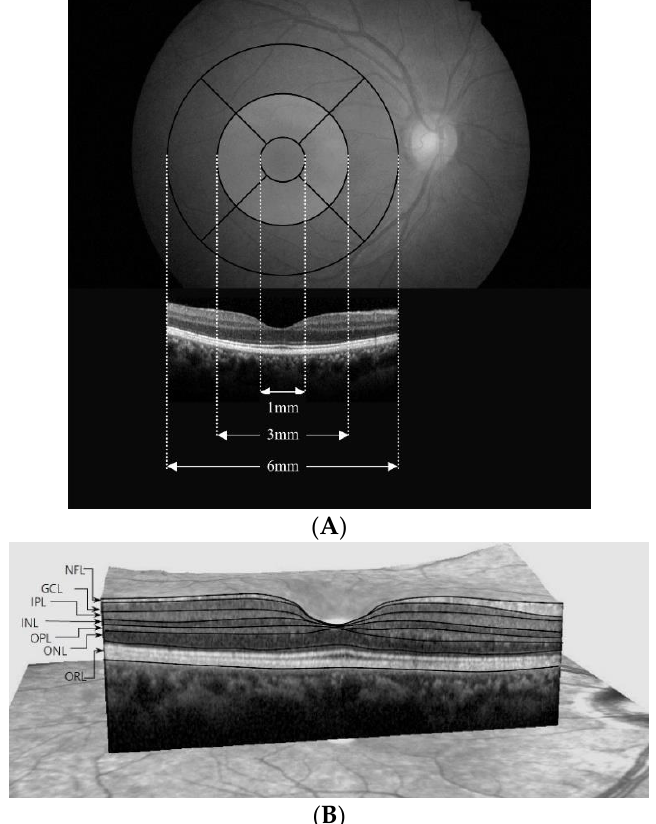
Figure 1. ( A ) The Early Treatment Diabetic Retinopathy Study area and spectral-domain optical coherence tomography (OCT) B-scans overlapped to the fundus. Foveal center thickness was defined as the mean value obtained at the foveal center from the horizontal and vertical scans. The thicknesses of inner locations, superior, inferior, nasal, and temporal, were the average measurements take at 490 μm and 500 μm in either direction from the foveal center. The thicknesses of the corresponding outer locations were defined as means measuring 1490 μm and 1500 μm in either direction from the foveal center. The thickness of each retinal layer was the sum of nine subfields. ( B ) Description of retinal segmentation of spectral-domain OCT. The segmented view of each retinal layer was labeled by the automated segmentation algorithm (with manual correction). NFL, Retinal nerve fiber layer; GCL, Ganglion cell layer; IPL, inner plexiform layer; INL, Inner nuclear layer; OPL, Outer plexiform layer; ONL, Outer nuclear layer; ORL, Outer retinal